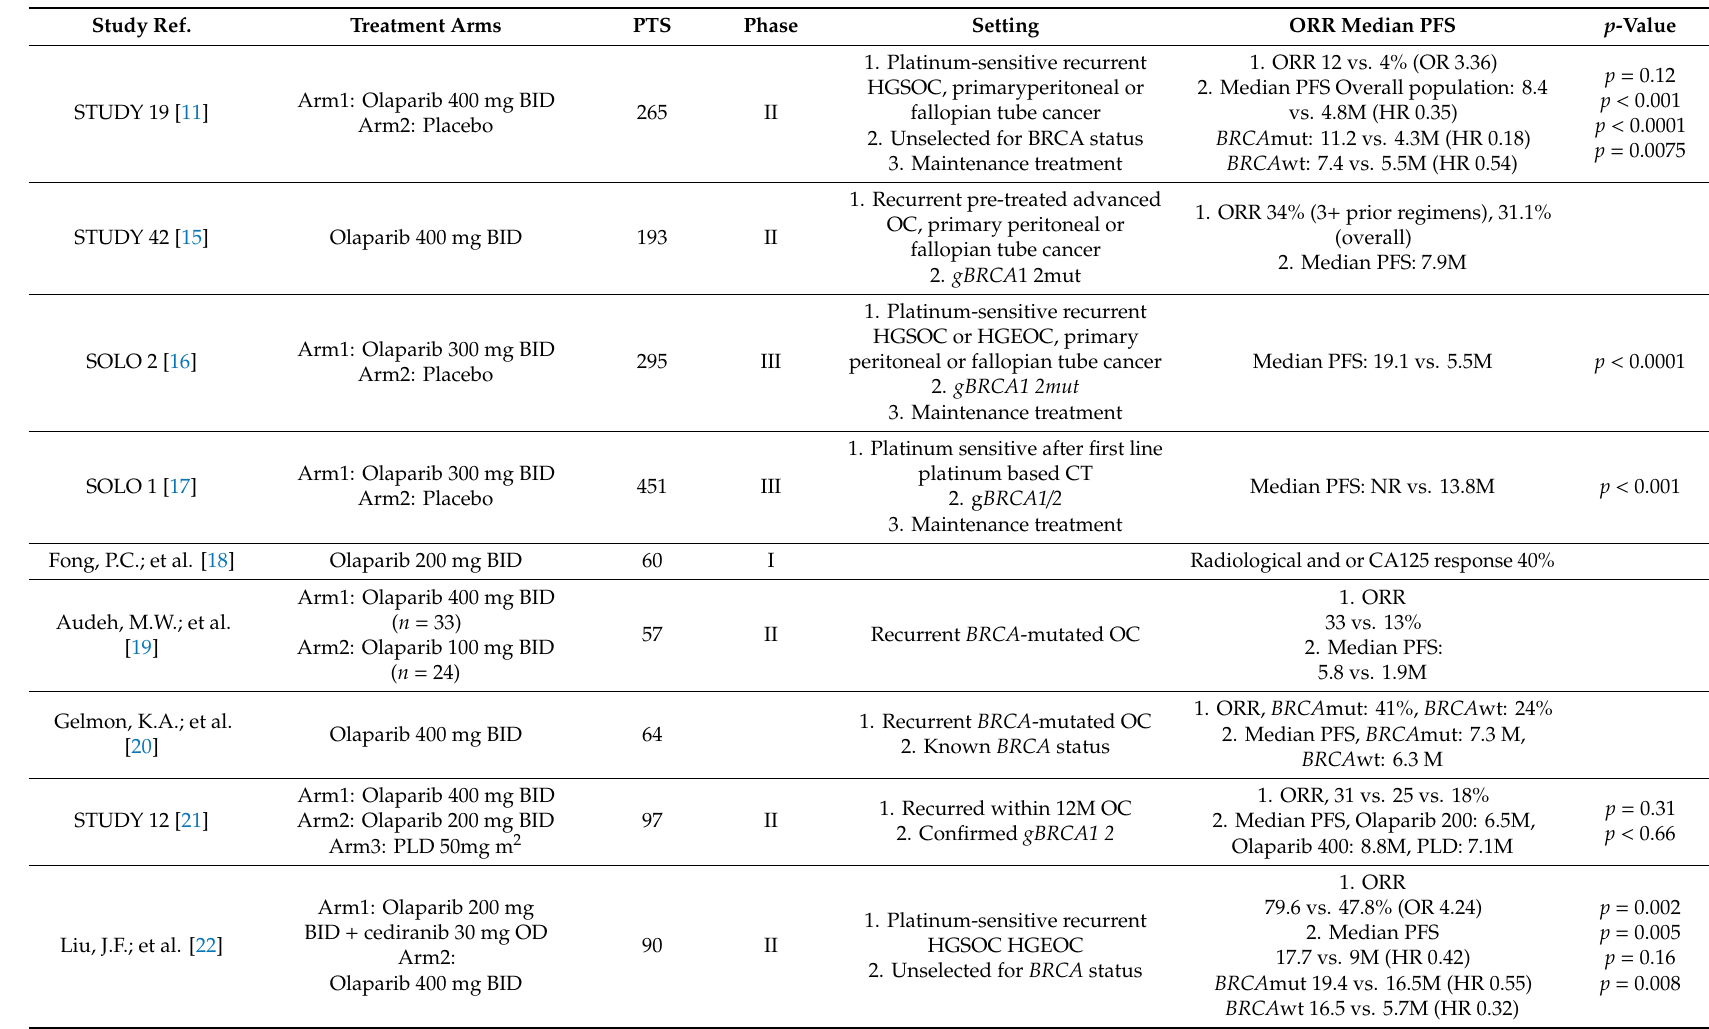
Table 1. Clinical trials results for Olaparib in ovarian cancer